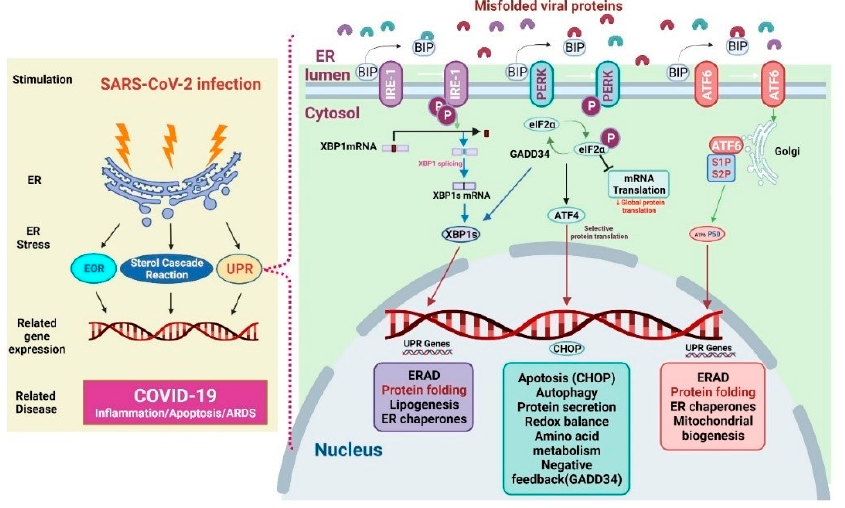
Figure 2. Mechanisms of endoplasmic resticulum (ER) stress and unfolded protein response (UPR) in COVID-19